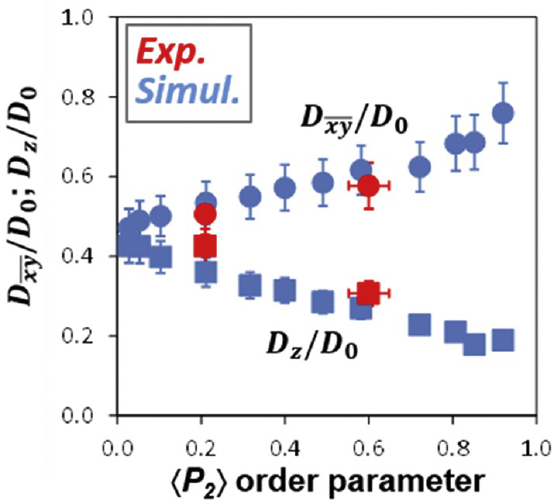
Figure 19. Influence of the preferred orientation of particles (cid:104) P 2 (cid:105) on the water self-diffusion tensor measured (red) and simulated (blue) within a collection of clay samples with the same porosity. The z-direction is perpendicular to the preferred alignment of clay platelets. Reprinted from Ref.